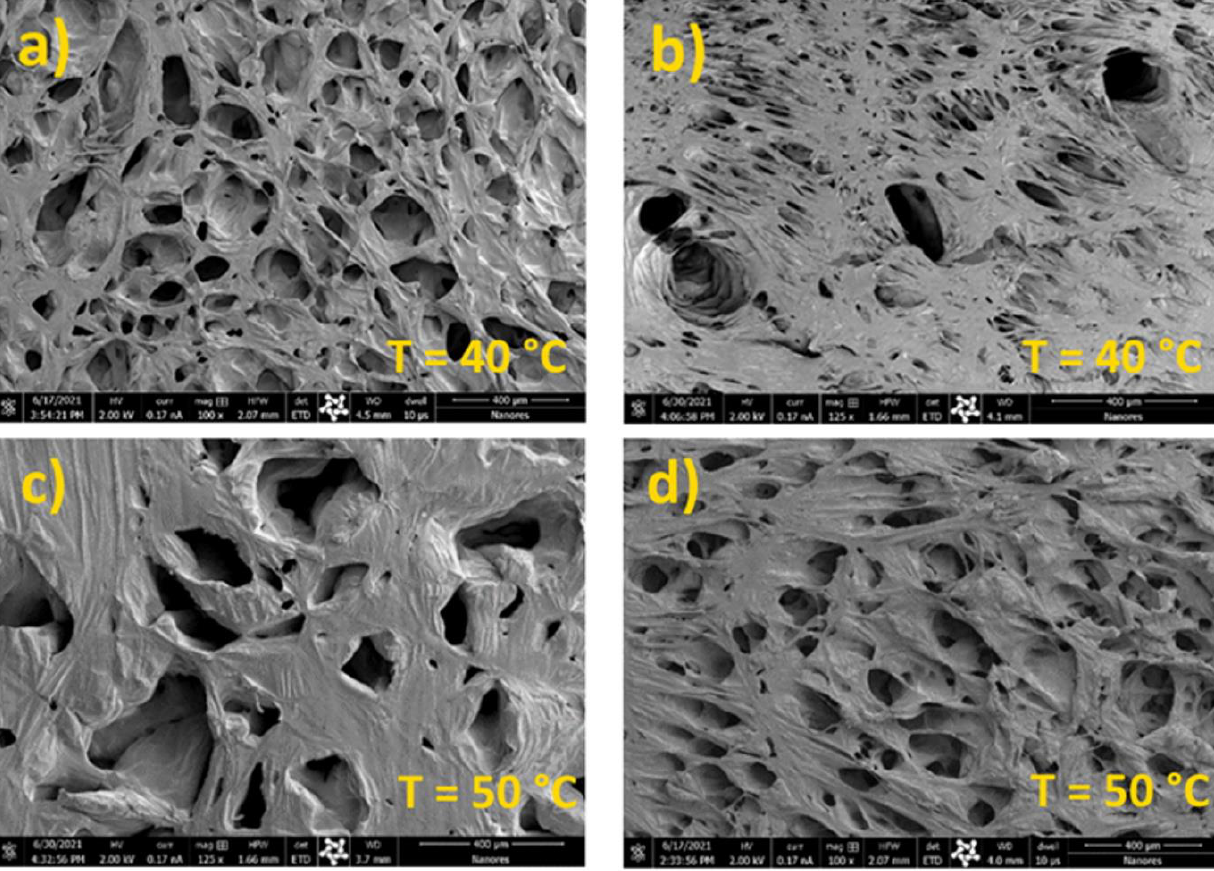
Figure 6. Effect of decompression type on the morphology of the neat PCL at T = 40 °C ( a,b ) and T = 50 °C ( c,d ): ( a,c ) one-step decompression; ( b,d ) two-step decompression. T = 50 ◦ C ( c , d ): ( a , c ) one-step decompression; ( b , d ) two-step